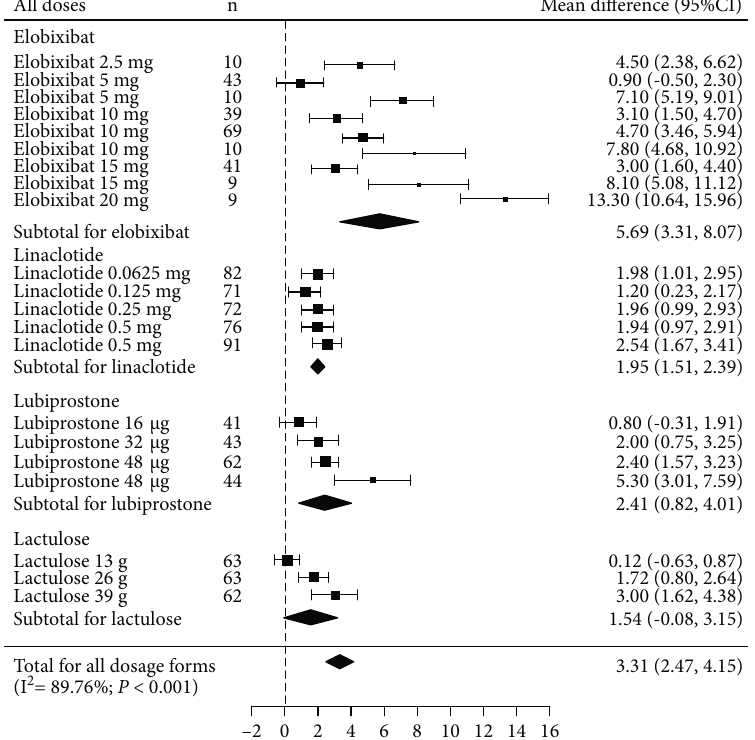
Figure 3: Forrest plot of random-e ff ects meta-analysis results in change in weekly SBMs compared between all doses. SBM: spontaneous bowel